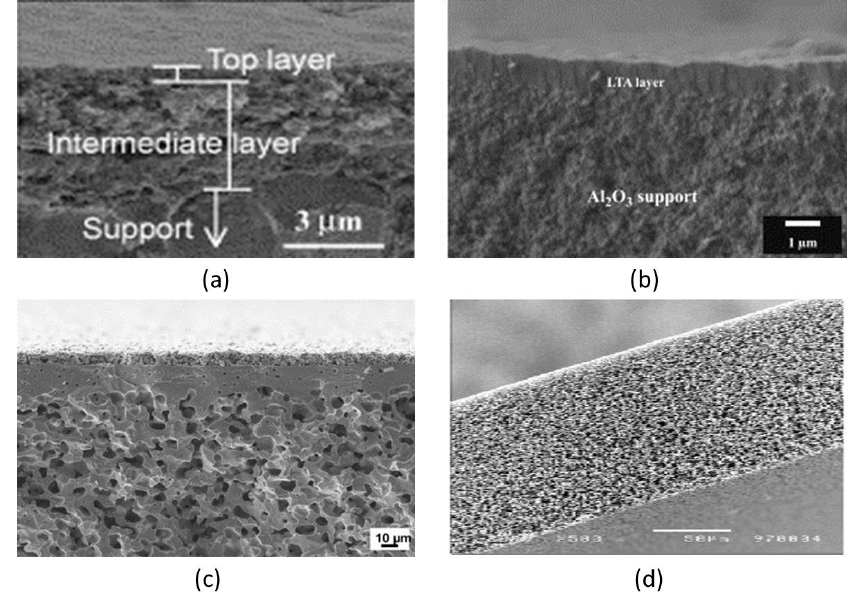
Figure 3. SEM image of ( a ) porous [35] ( b ) dense [36]; ( c ) asymmetric [37], and ( d ) symmetric inorganic membrane [38].